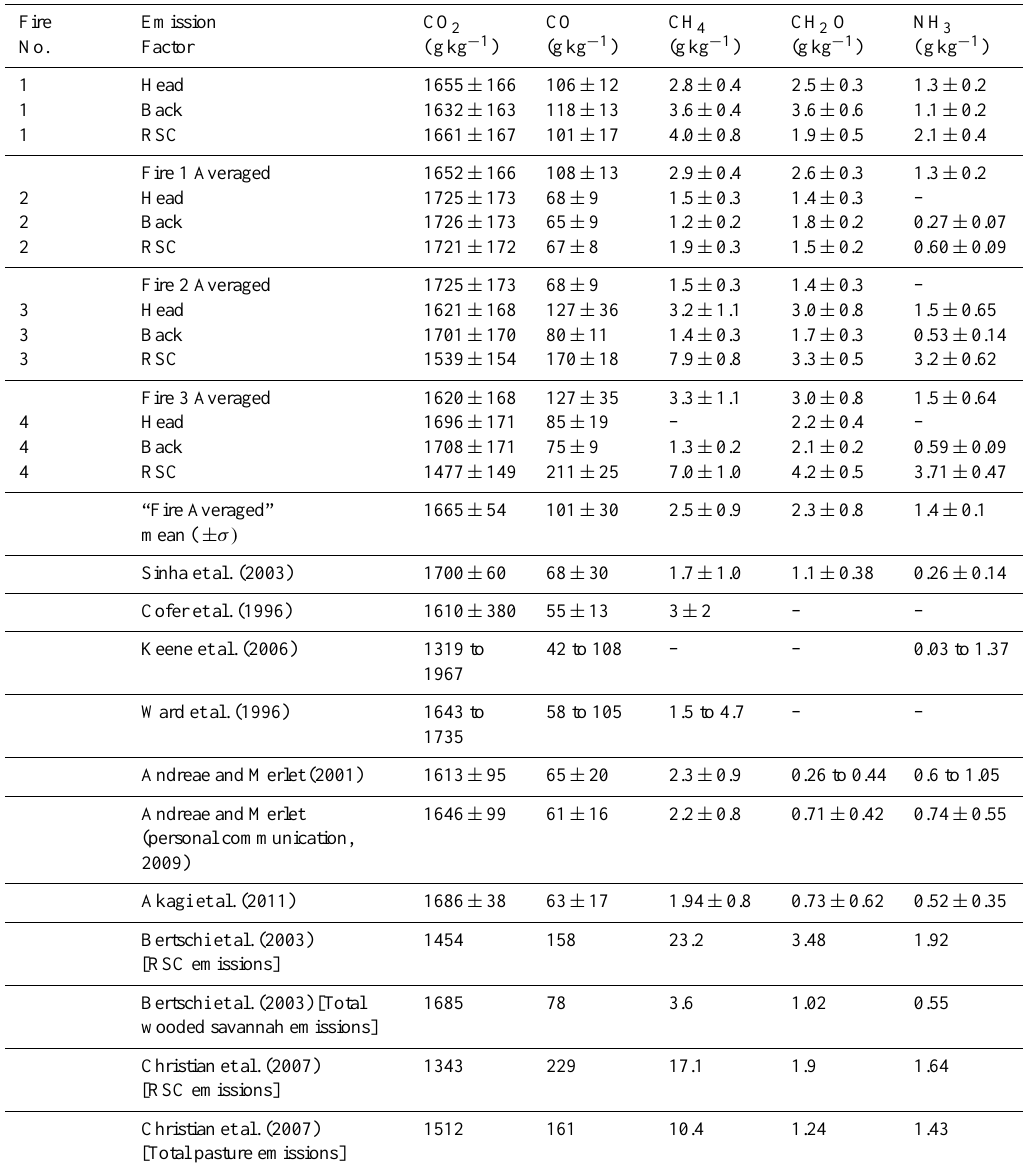
Table 4. Emissions factors (gkg − 1 of dry fuel burned) determined for the backfire, headfire and residual smouldering combustion (RSC) stages of Fires 1 to 4 using methods described in Sect. 4.2. EFs based on poorly constrained ERs (see Table 3 and Fig. 8) are not shown. “Fire averaged” EFs are calculated using the stage-specific EFs weighted by the FRE-determined proportion of fuel burned in each stage (apart from for Fire 4 where FRE data are unavailable). Weighted mean EF and its associated uncertainty, calculated according to Taylor (1997), is also shown. Comparison EFs for the same geographical area derived in four different studies using a variety of sampling and measurement techniques are listed, as are those for the “savannah and grassland” category reported in the widely used EF database of Andreae and Merlet (2001) and its more recent updates, and the “savannah” category of the recent EF review by Akagi et al. (2011). We also include EFs from the study of Bertschi et al. (2003), where the FTIR-derived emissions factors for a group of tropical wooded savannah logs from Zambia were measured whilst undergoing RSC, and used to calculate a “total” fire integrated wooded savannah EF in combination with EF measurements from lofted emissions sampled via airborne FTIR. The simple linear model adopted by Bertschi et al. (2003) for the wooded savannah assumed that 10% of all fuel consumption occurred in RSC combustion, and the remainder in combustion that resulted in emissions of the sort sampled by the lofted emissions measurement approach. Finally we include EFs for a follow on study of RSC performed by Christian et al. (2007) in Brazil, quoting both the EFs of logs undergoing smouldering combustion, and the total EF of pasture fires including a 40% contribution from